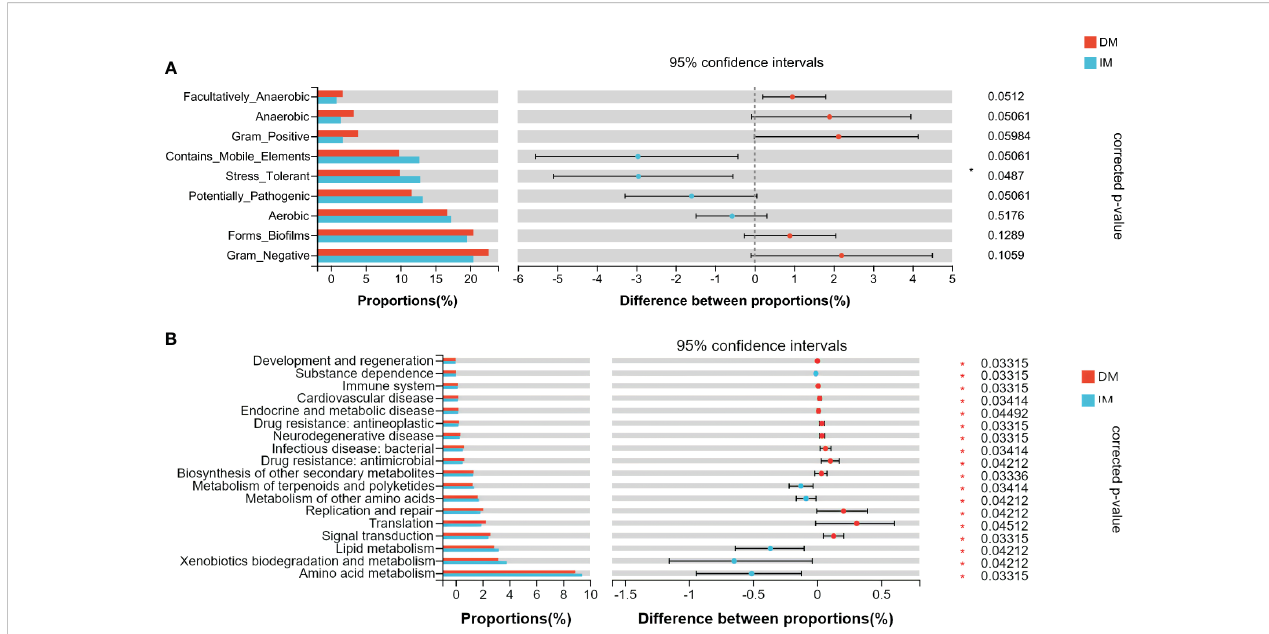
FIGURE 7 The difference of gut microbial phenotype and KEGG functional pathway between the two groups of SCRC patients. (A) The results of microbiome phenotype prediction by BugBase. (B) The signi fi cantly different KEGG pathways between the two groups by PICRUSt2. *q <